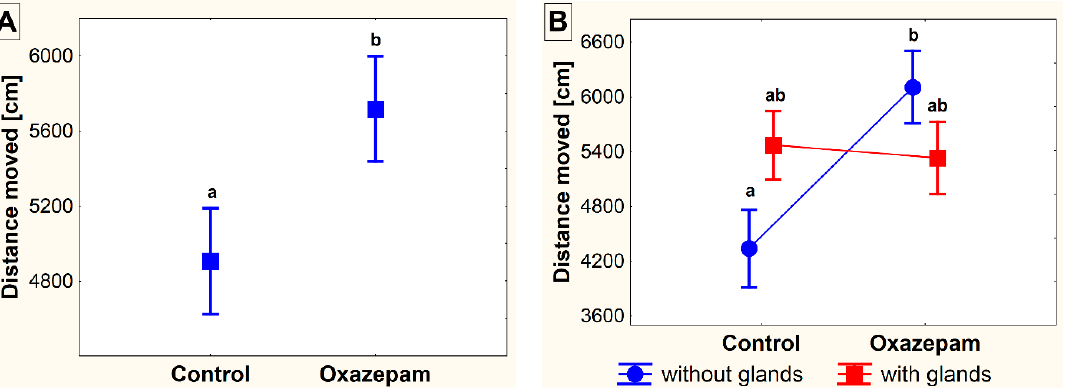
Figure 1. The distance moved (in cm) of marbled crayfish ( Procambarus virginalis , Lyko 2017) exposed to oxazepam (~1 µg L − 1 ) and of the control animals in the conditions without available shelter ( A ). The differences detected between the groups of crayfish and in accordance with the presence of developed glair glands ( B ). The different superscripts show significant differences ( α = 0.05) among groups. Data are presented as mean ± standard error of mean.